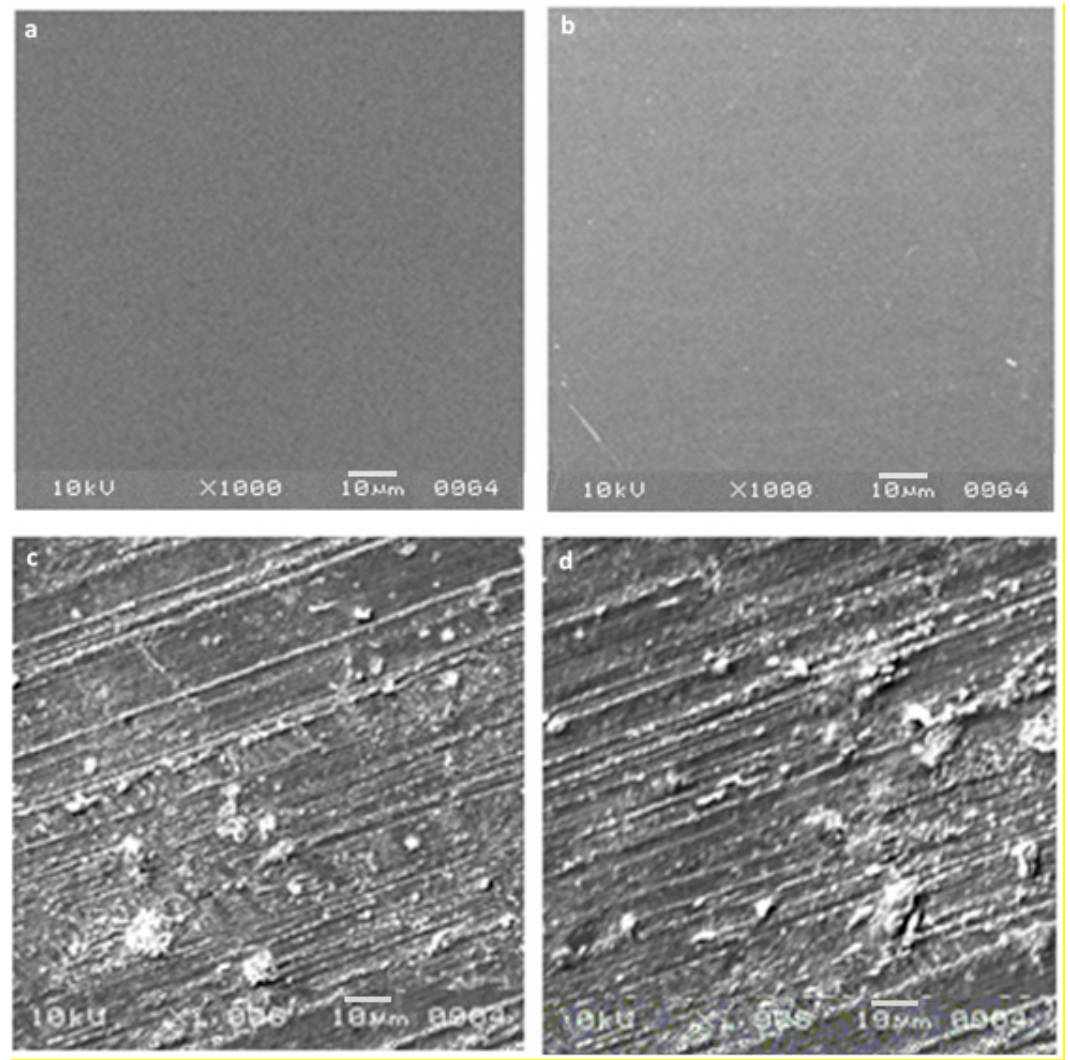
Figure 7. Scanning electron microscopy (SEM) morphologies of pure PVA film ( a ), unirradiated PVA/NBT ( b ) and irradiated PVA/NBT films with 10 mGy ( c ) and 20 mGy ( d ).